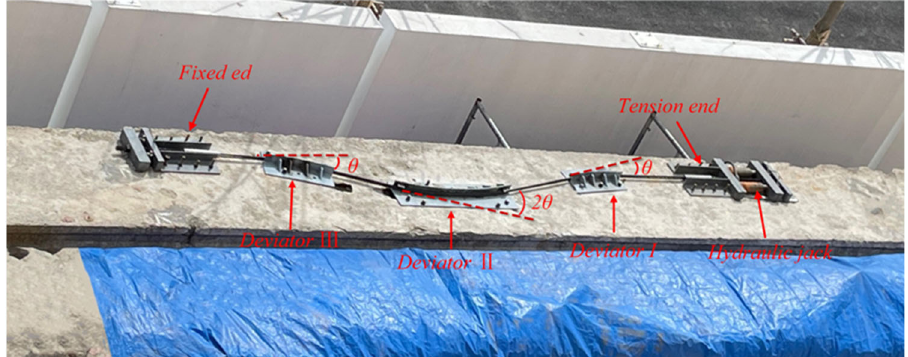
Figure 5. Arrangement diagram of the three ‐ continuous ‐ bending test device.